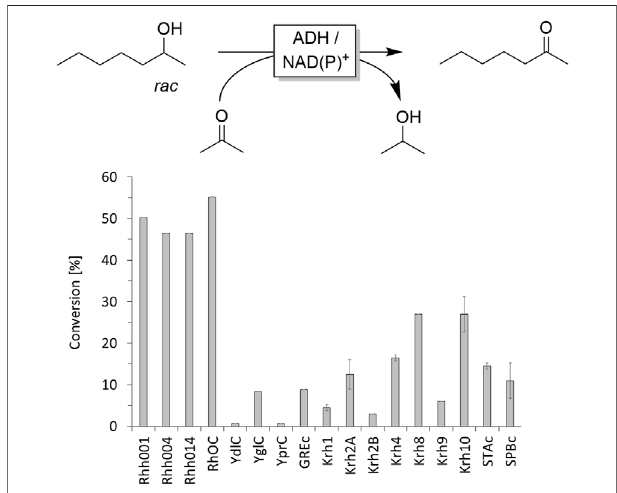
FIGURE 1 | Screening of commercial alcohol dehydrogenases for oxidationof rac -heptan-2-ol.Reactionconditions:[ rac -heptan-2-ol]=10 mM, [acetone] = 10% v/v, [NAD + ] = 0.5 mM or [NADP + ] = 0.5 mM, [ADH] = 1 mg×mL − 1 , [KPi, pH 7] = 50 mM, total volume: 500 μ L, T = 30 ° C, reactiontime:24 h,600 rpm.Dataareexpressedasthemean±SDofthetwo independent experiments performed in technical duplicates. ADHs derived from a ketoreductase screening kit from Codexis. For the NAD + -dependent ADHs Rh001, Rh004, Rh014, RhOC and YglC NAD + was applied as cofactor whereas for the NADP + -dependent ADHs YdlC, YprC, GREc NADP + was used.SincefortheADHsKrh1,Krh2A,Krh2B,Krh4,Krh8,Krh9,Krh10,STAc and SPBc no cofactor preference was provided, a mixture of both NAD + and NADP + was used for the